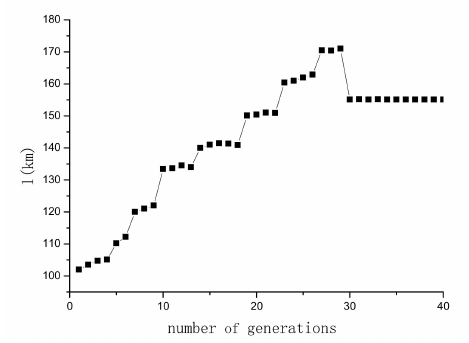
Figure 10. l convergence